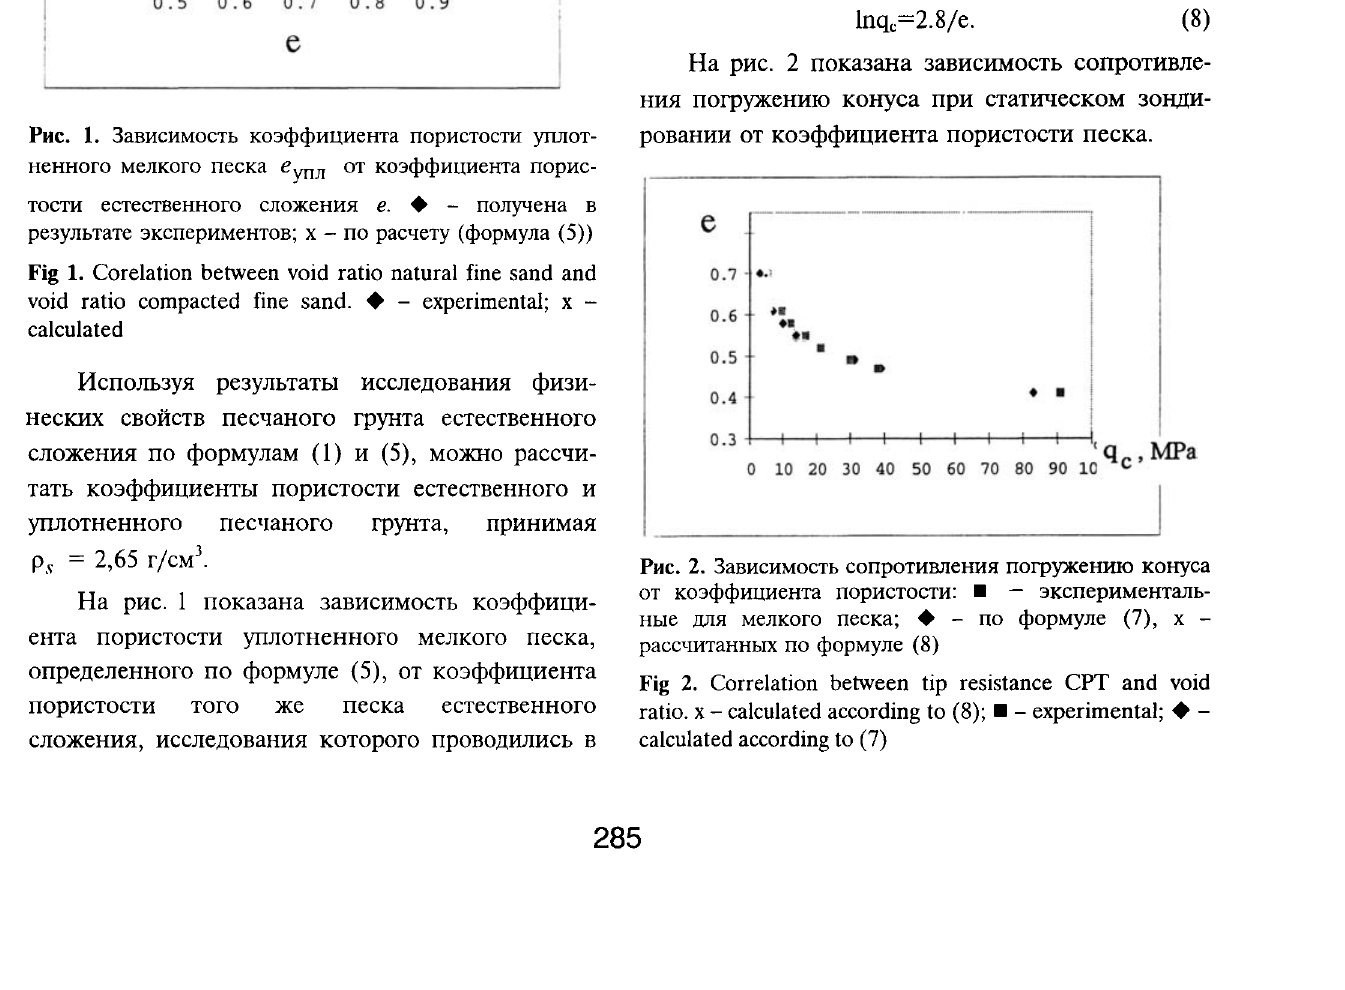
Fig 2. Correlation between tip resistance CPT and void ratio. x- calculated according to (8); • -experimental; + - calculated according to